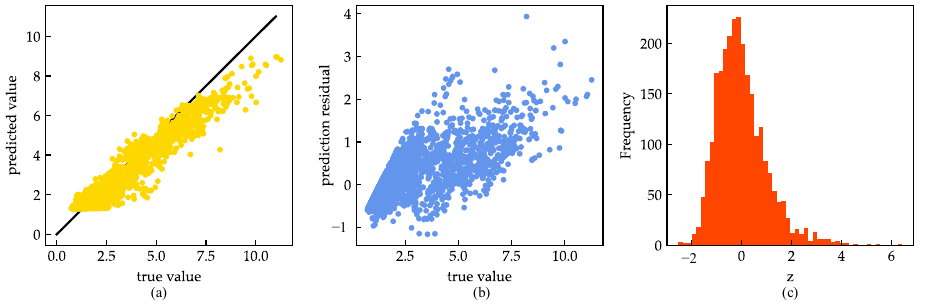
Figure 7. The prediction performance of XGBoost: ( a ) The scatter plot between predicted value and true value; ( b ) The scatter plot between prediction residual and true value; ( c ) The histogram of z in the model.